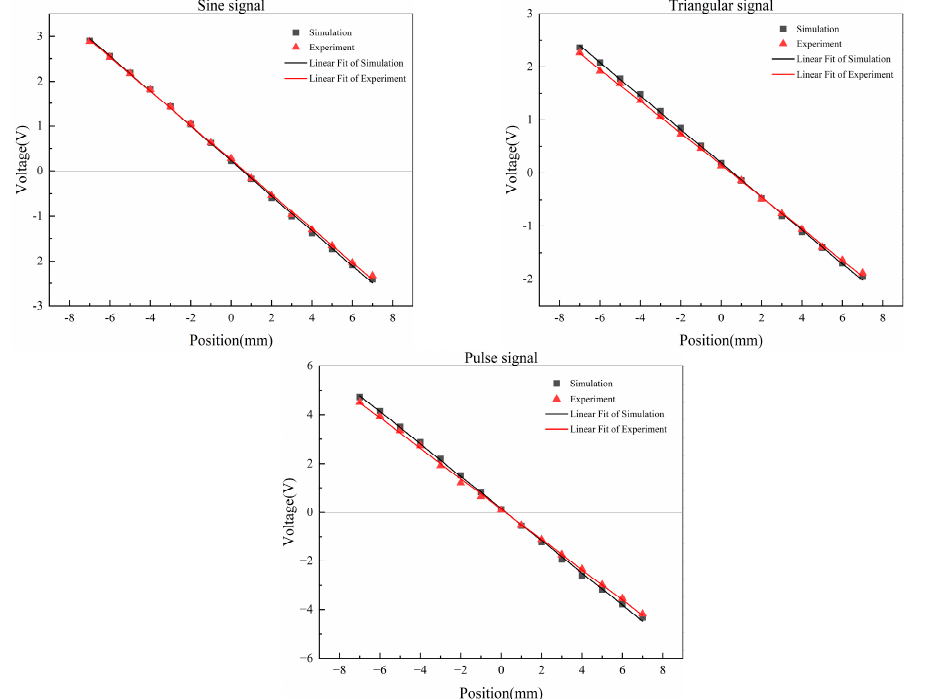
Figure 14. Comparison of simulation and test under three excitation signals.